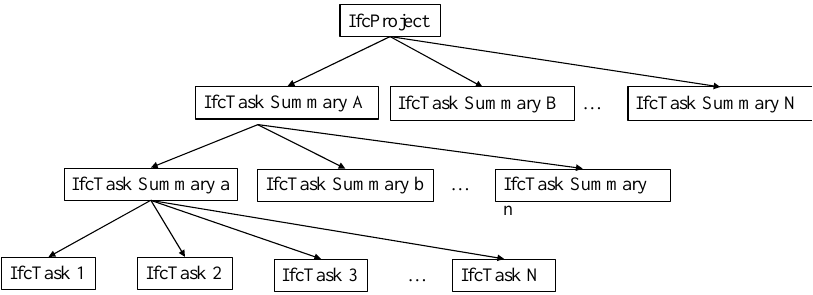
Figure 8. Entities reference relationship in an IFC file.